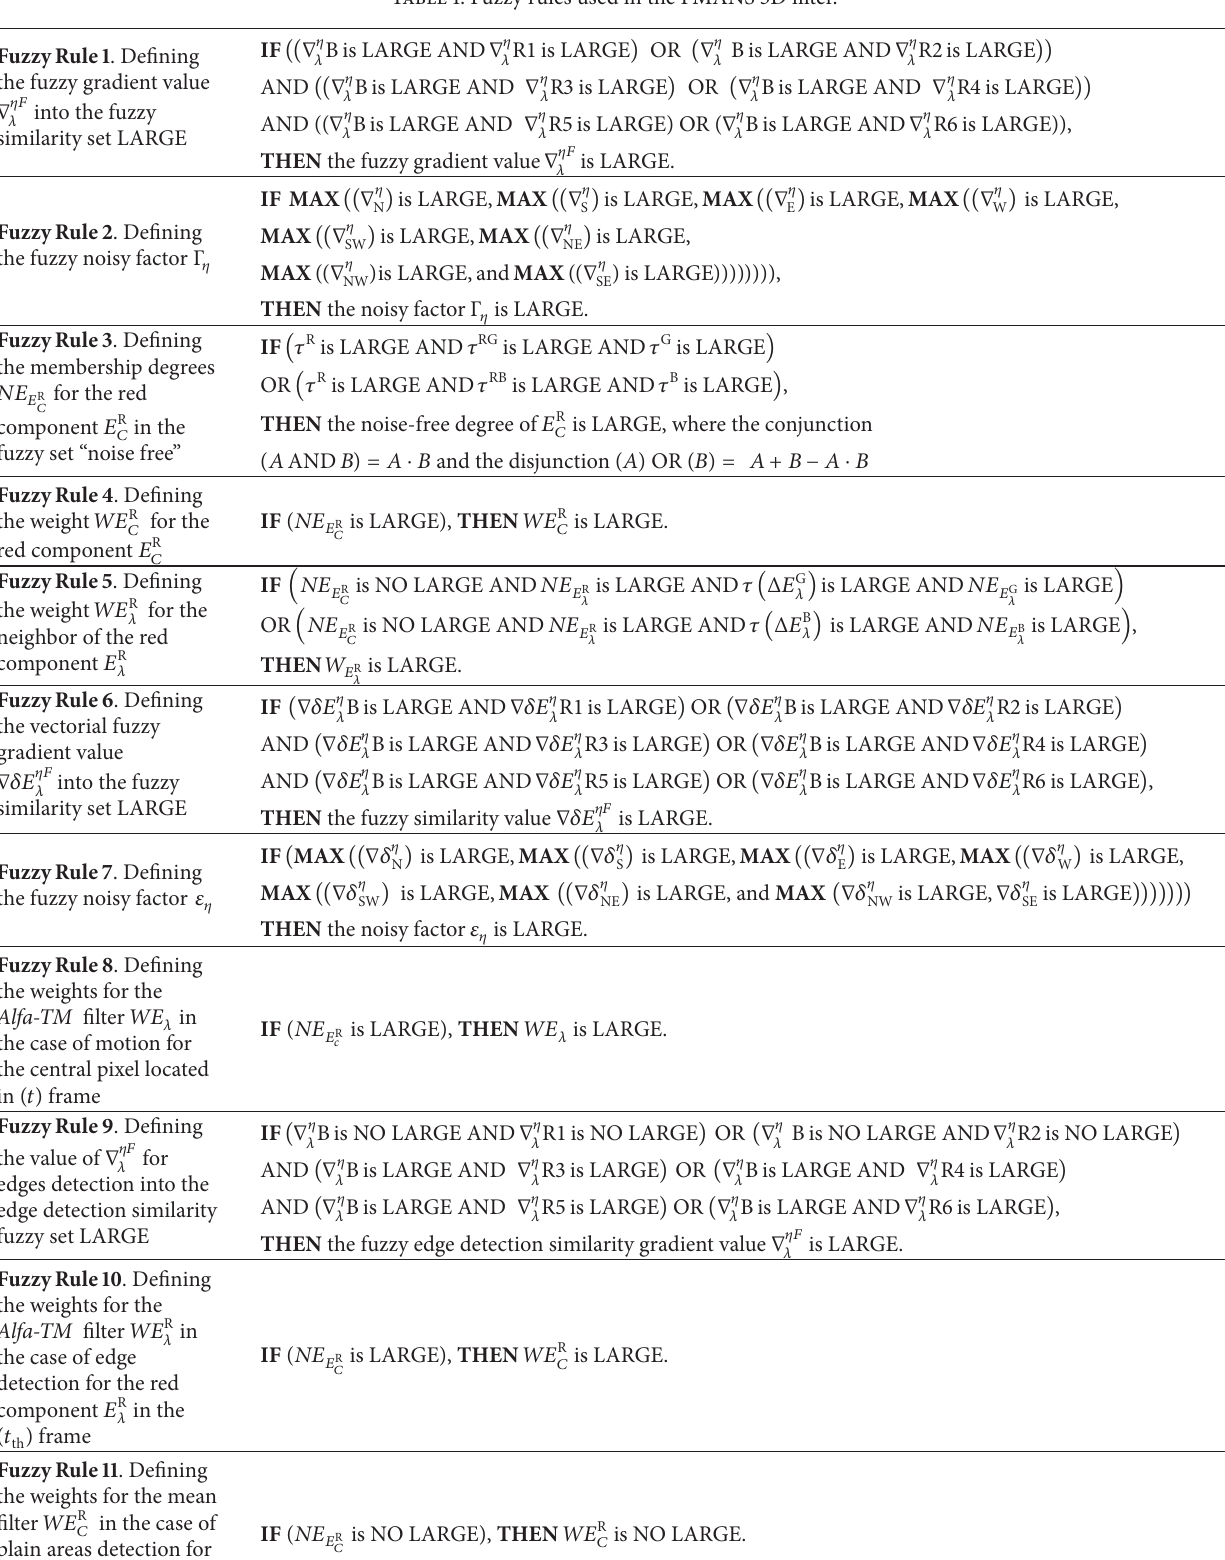
Table 1: Fuzzy rules used in the FMANS 3D